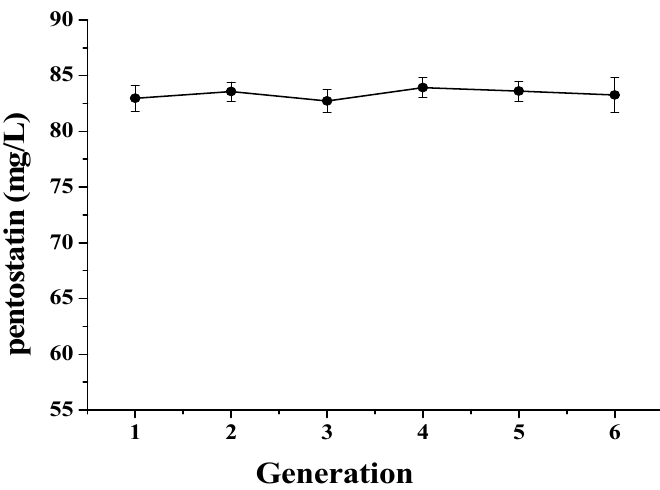
Figure 4. The genetic stability of the mutant Actinomadura sp. S-15 in six generations.